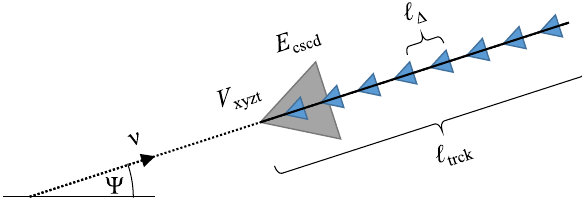
Fig. 8 Sketch of the eight-dimensional event model for a neutrino ν incoming at angle (cid:15) = (ϑ,ϕ) and interacting at vertex position and time V xyzt . The cascade part is modeled as a single Cherenkov emitter (gray color) placed at the vertex in the same direction as the incident neutrino, and scaled by the expected number of photons per energy E cscd . The track part consists of n (here n = 8) emitters (blue color) placed at distances (cid:17) (cid:5) along the track to reach the full length of (cid:17)